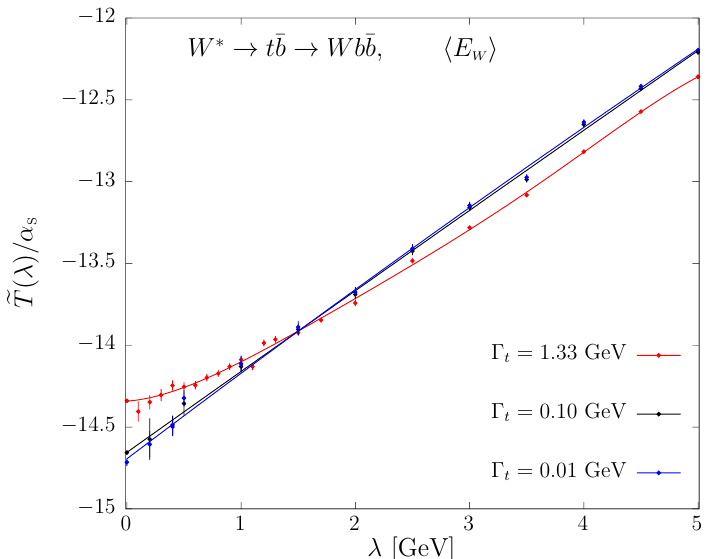
Figure 11 . Small (cid:21) behaviour of e T ( (cid:21) ) for h E and the black solid lines are a parabolic (cid:12)t of the computed points, the red line is the same one displayed in (cid:12)gure